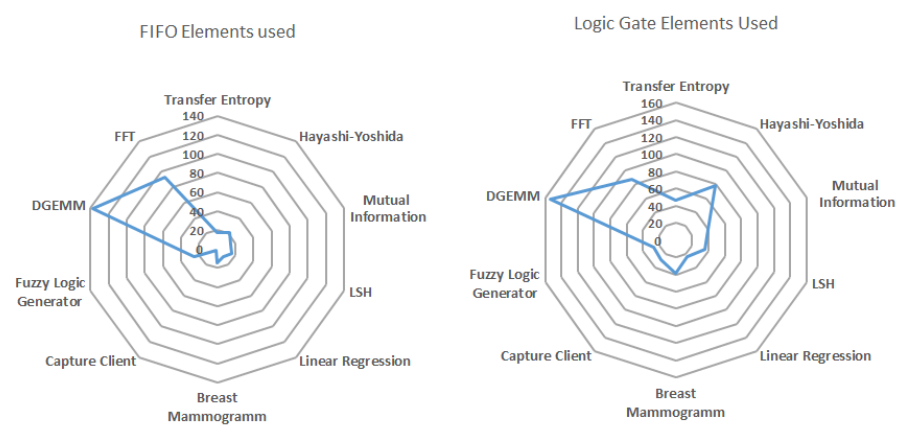
Figure 2. Spider graphs reporting the number of FIFO and logic gate elements used in the 10 sample